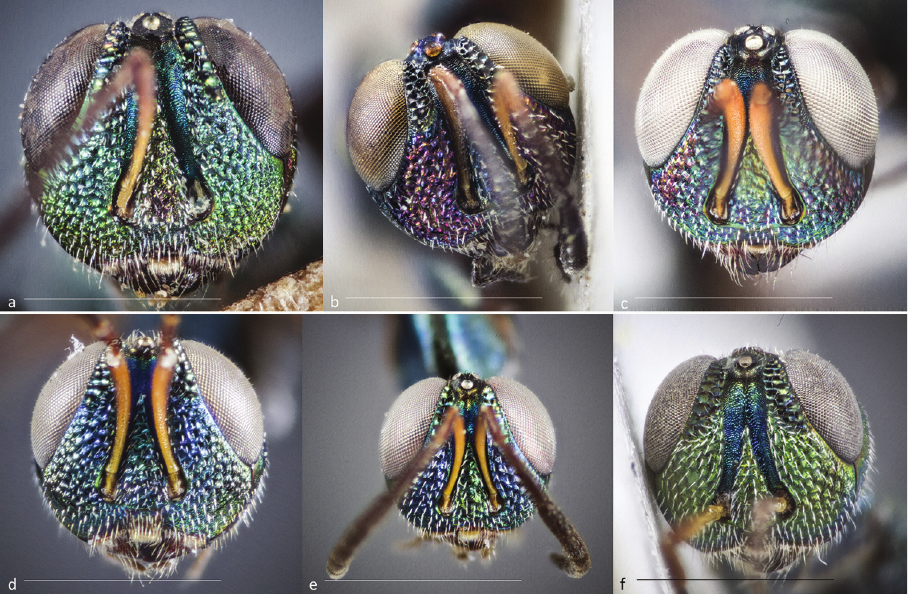
Figure 5. Head (frontal) I a O. ahoma (Mani & Kaul) (imaged specimen: OAh01, holotype) b O. circu- laricollis sp. n. (OCi01, holotype) c O. felix sp. n. (OFe01, holotype) d O. fidelis sp. n. (OFi01, holotype) e O. florea sp. n. (OFl01, holotype) f O. formosa (Giraud) (OFo03). Scale bars: 1 mm.